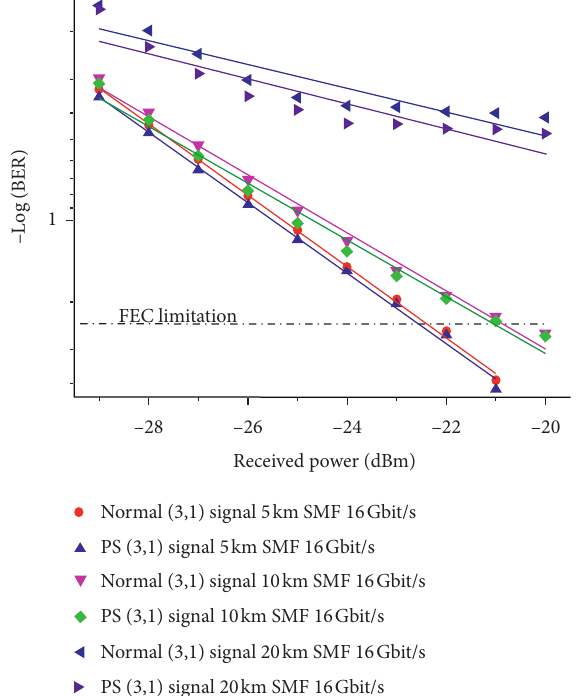
Figure 9: BER of the normal (3, 1) signal and the PS (3, 1) signal versus received optical power for 5km, 10km, and 20 km SMF transmission at 16 Gbit/s,